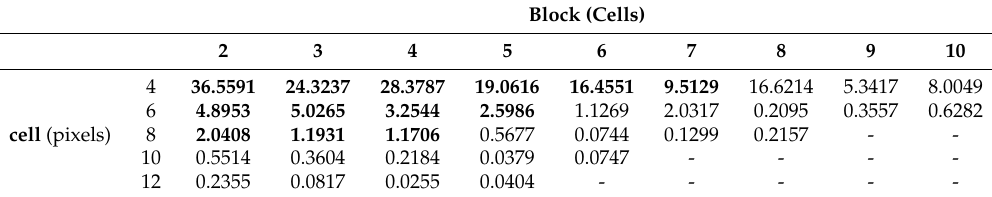
Table 5. The time consumption (min) per iteration of Algorithm 1 versus different (cell, block)s. Block